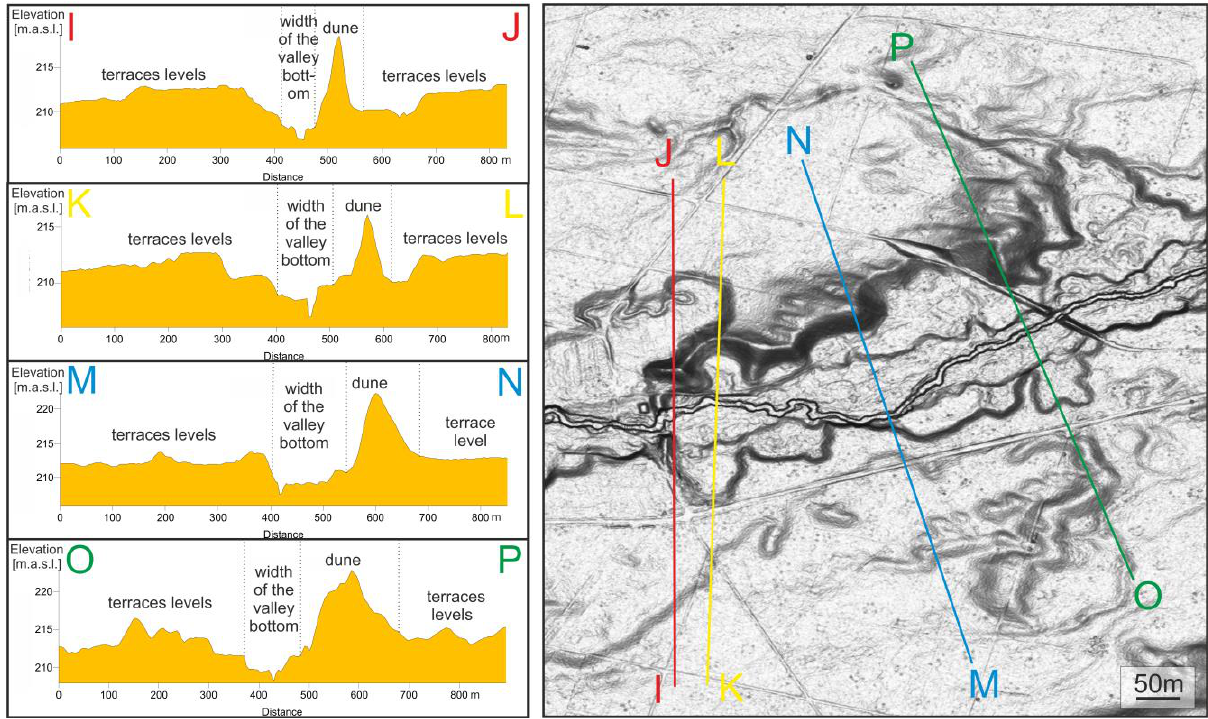
Fig. 5. Location of the former Regolowiec ironworks on the shaded relief map with cross section lines representing valley relief indicated Fig. 6. Location of the former Brusiek ironworks: 5 – on the shaded relief map; 6 – on the coloured contour